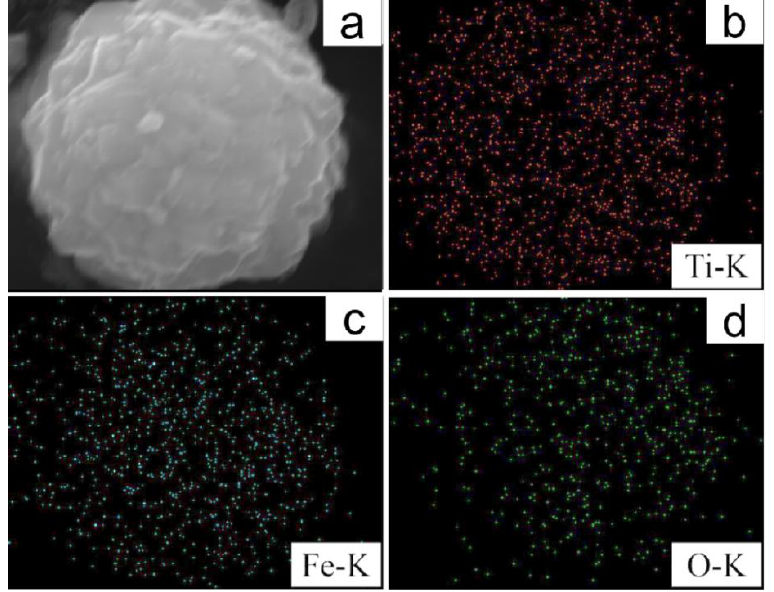
Figure 4. ( a – d ) Ti, Fe, and O elemental mapping.